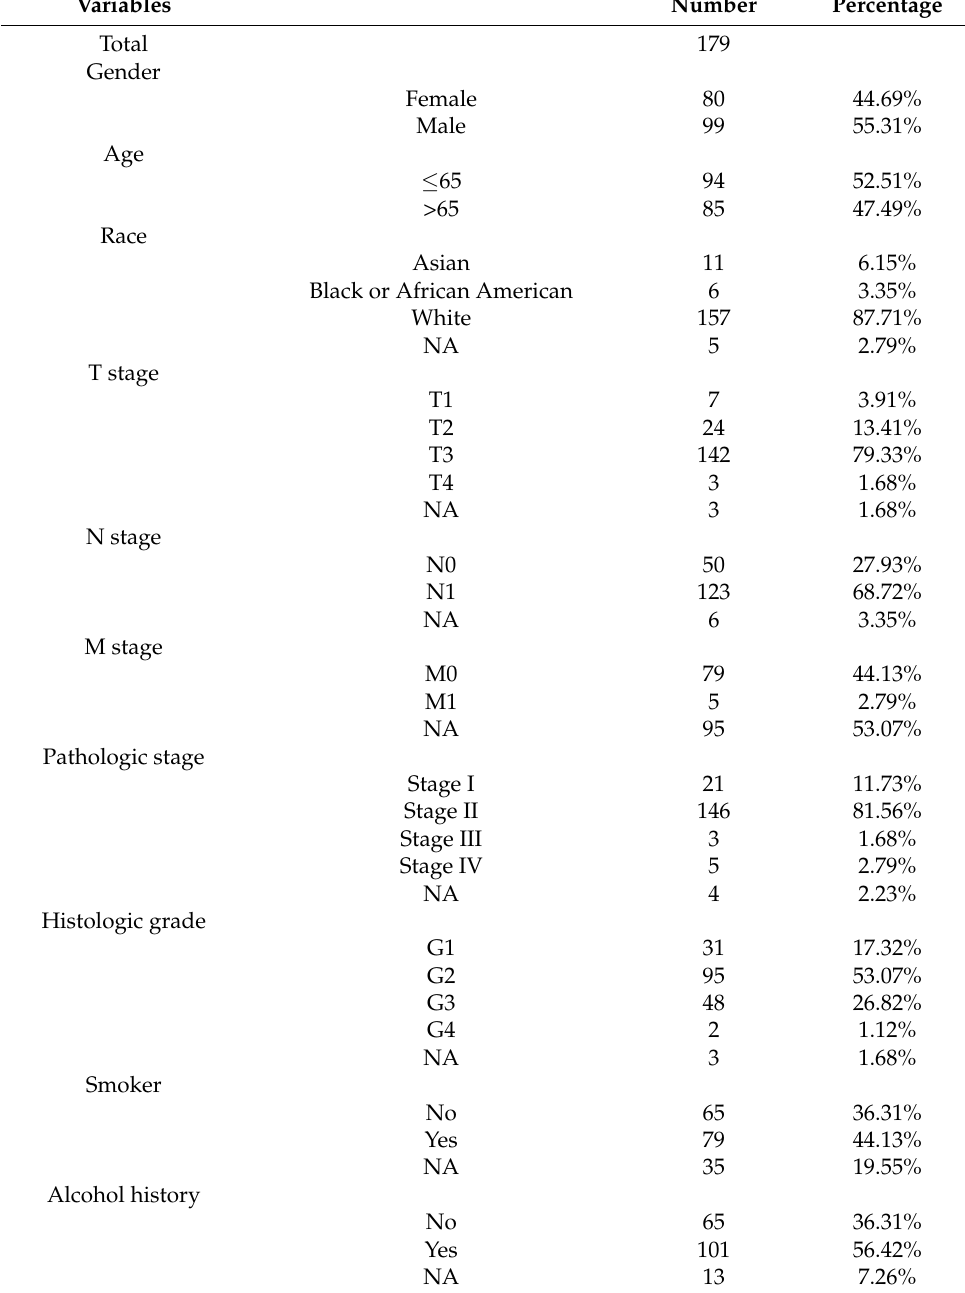
Table 1. Clinicopathological features of 179 patients from the TCGA − PAAD